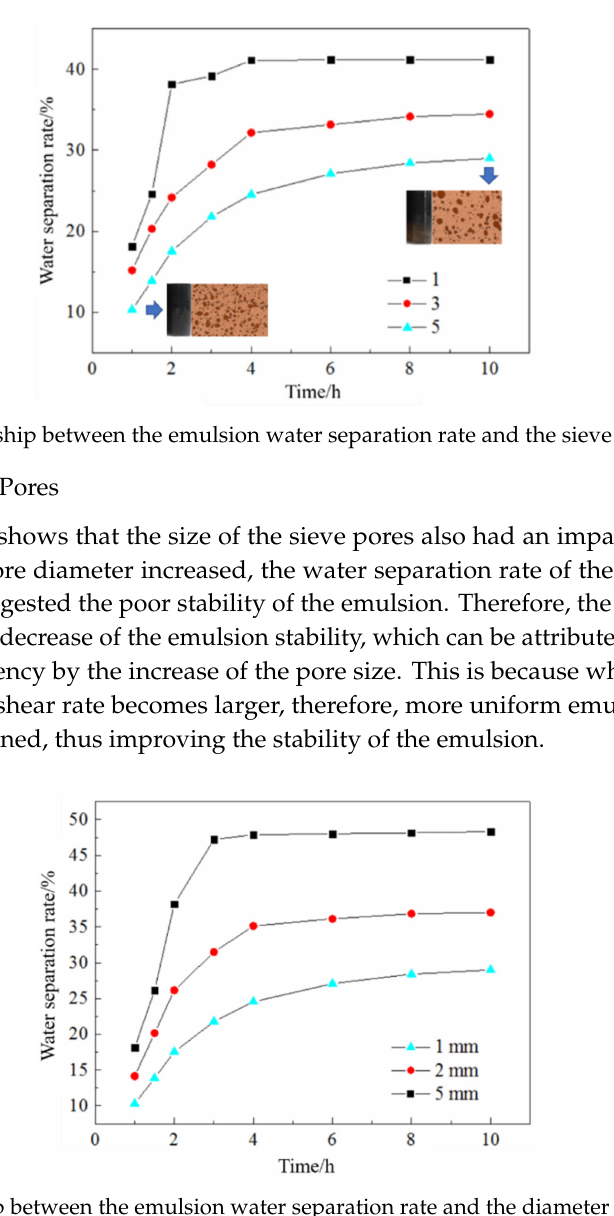
Figure 5. Relationship between the emulsion water separation rate and the diameter of the sieve pores (new